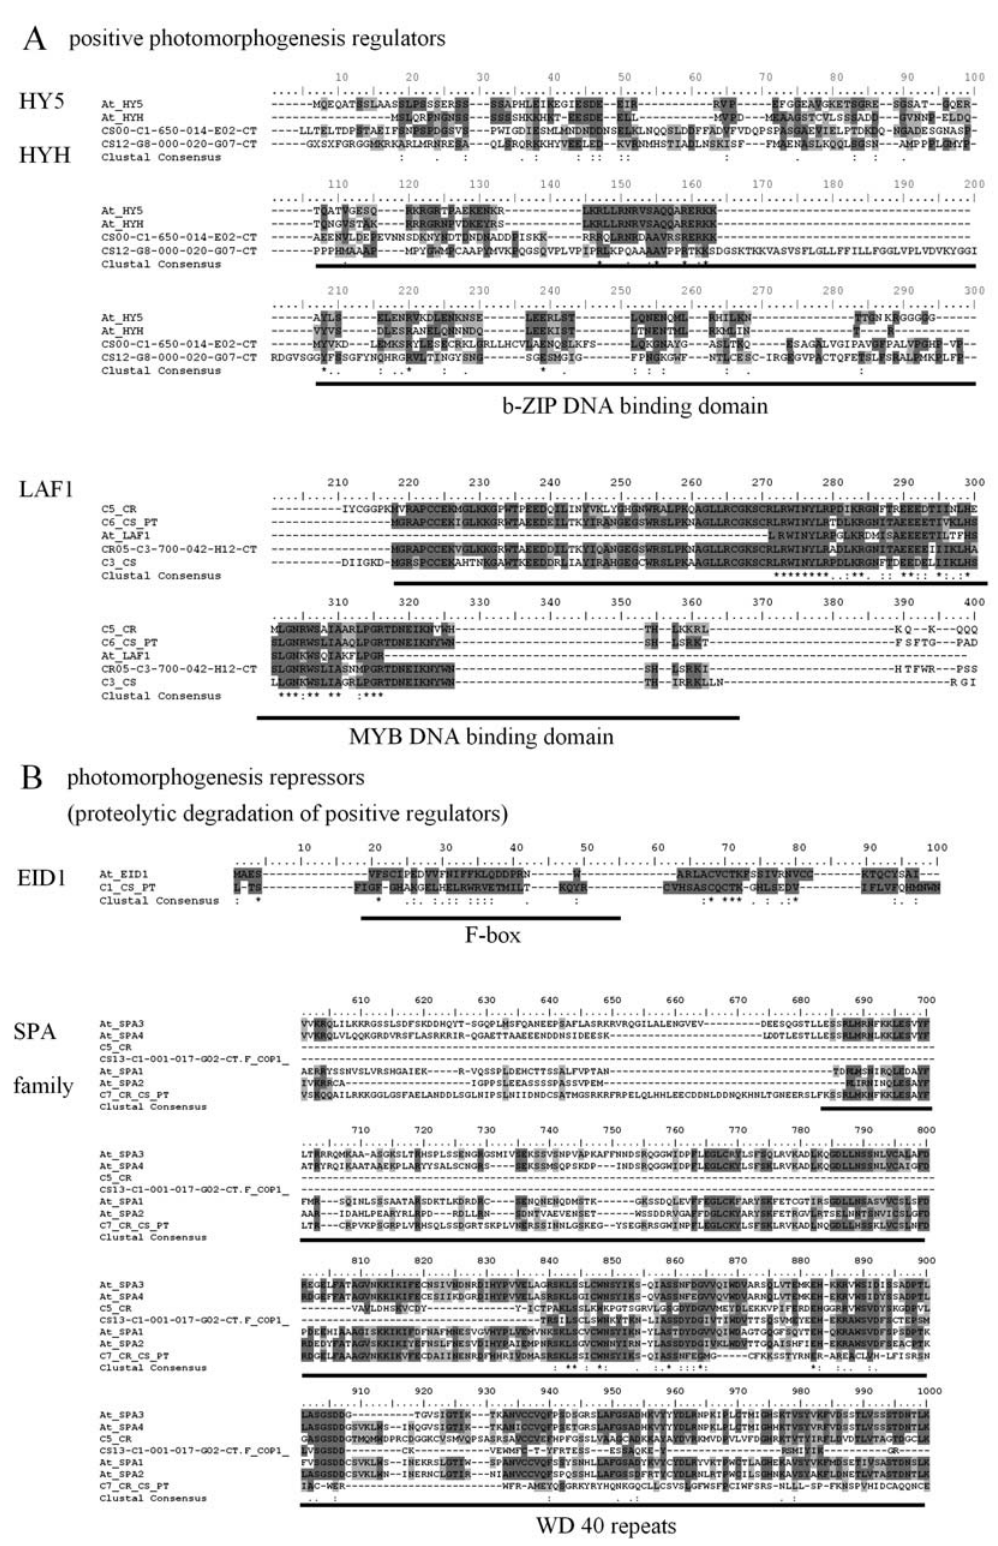
Figure 6 - Proteolysis-mediated photomorphogenesis control pathway in citrus. A. alignment of positive photomorphogenesis regulator families HY5/HYH and LAF1. B. alignment of negative photormorphogenesis regulator families EID1 and SPA1. Dark and light gray shading indicate sequence identity and similarity, respectively. At, Arabidopsis thaliana ; bZIP, basic leucine zipper; C, contig; CS, Citrus sinensis ; CR, Citrus reticulata ; PT, Poncirus trifoliata . Underlined sequence represents functional domains. Dark and light gray shading indicate sequence identity and similarity, respec-